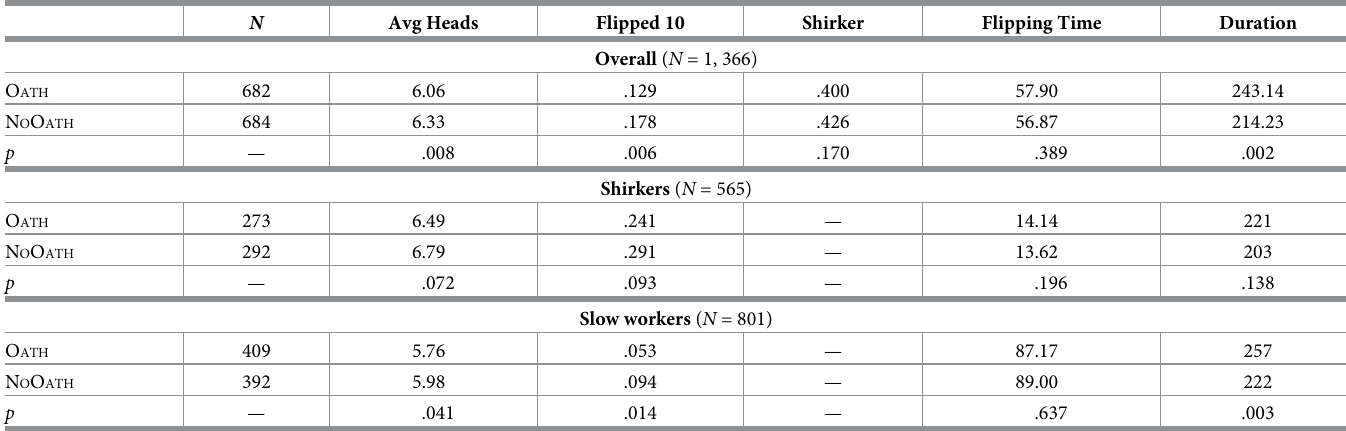
Table 2. Reporting behavior by treatment, and response